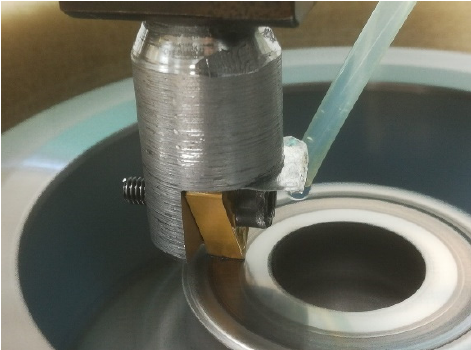
Figure 3. Detail of the contact between the surface of the workpiece and the tool tip.